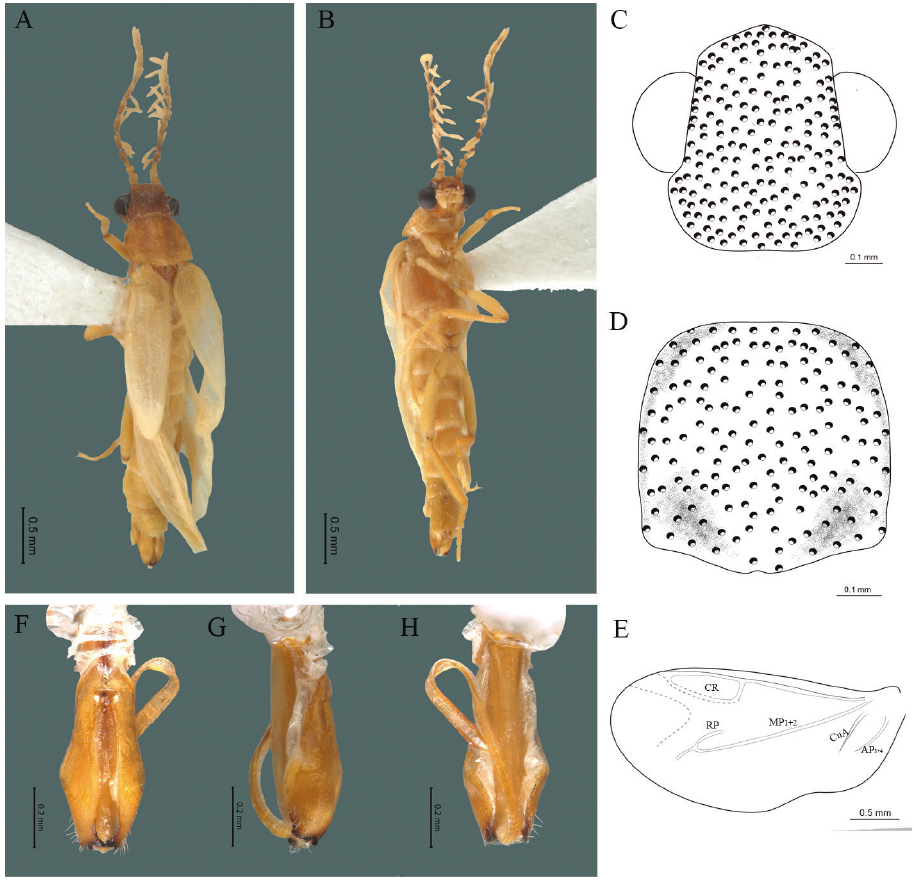
Figure 20. Cenophengus mumui Vega-Badillo et al. 2021, male. Habitus: A dorsal B ventral C head dorsal D pronotum dorsal E hind wing. Wing venation: CR = Radial Cell; RP = Posterior Radial vein; MP1+2 = Posterior Median vein; CuA = Cubital vein; AP = Posterior Anal vein. Aedeagus: F dorsal view G lateral view H ventral